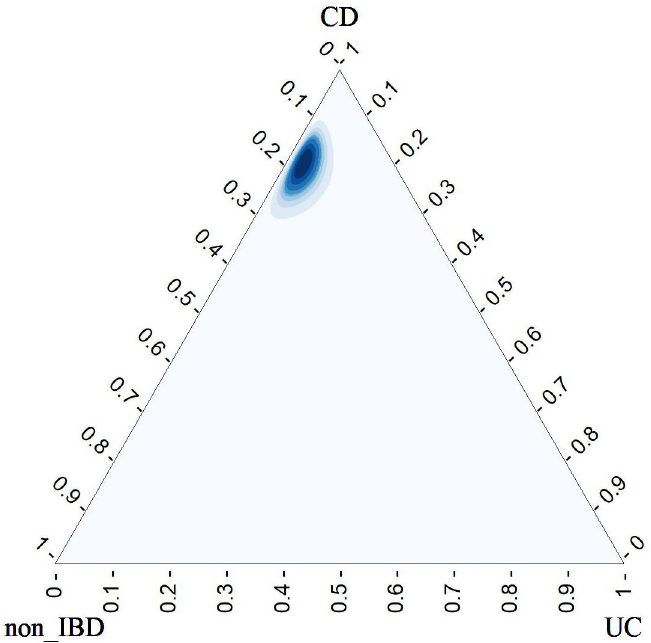
Figure 3. Posterior Dirichlet in A_CD